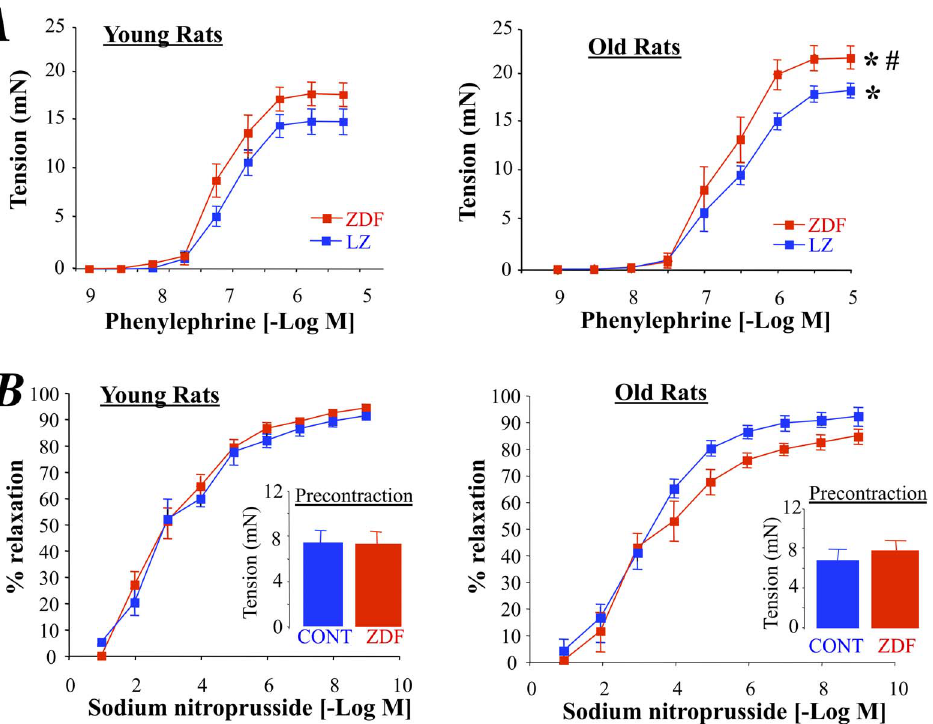
Figure 6. Concentration-response curves to phenylephrine (A) and sodium nitroprusside (B) performed in isolated arteries from young and old LZ and ZDF rats. The inserts in panels B represent the precontraction applied to arteries before sodium nitroprusside-mediated relaxation. Mean 6 SEM is presented (n=10 per group). *P , 0.05, old versus young rats # P , 0.05, ZDF versus LZ rats.